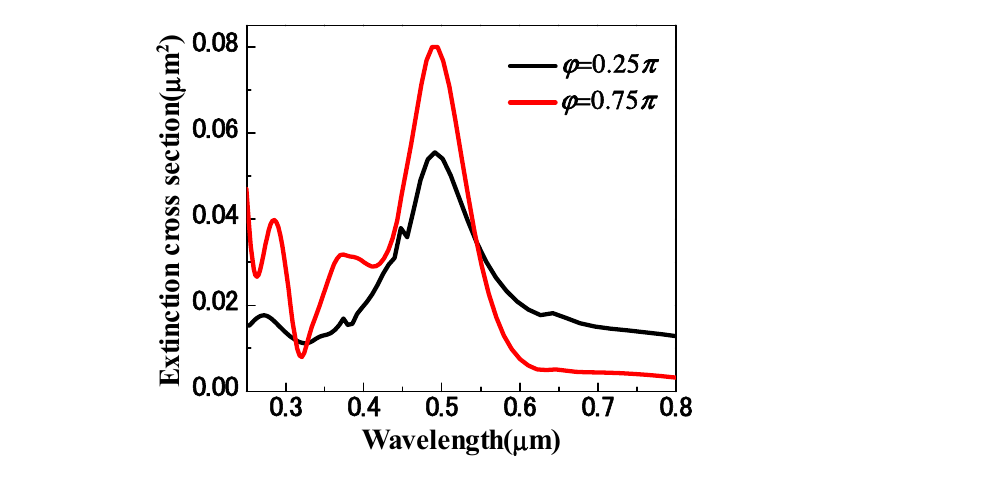
Figure 4. Comparison of the extinction cross section spectra for a 90 nm nanocubic silver particle with ϕ = 0.25 π and ϕ = 0.75 π .